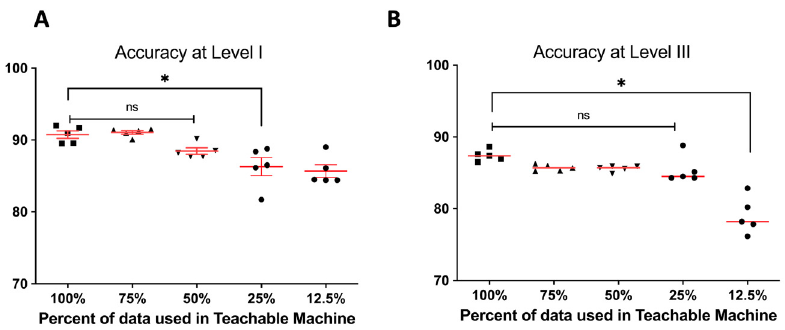
Figure 7. Accuracy of Teachable Machine ® according to the amount of data used in training and validation. ( A ). Mean accuracies of model according to the amount of data at Level I. (* indicates p - value less than 0.05 with Mann–Whitney test, ns meant non-significant difference). ( B ). Performance of Teachable machine according to the number of images at Level III (* indicates p -value less than 0.05 with Mann–Whitney test, ns meant non-significant difference).